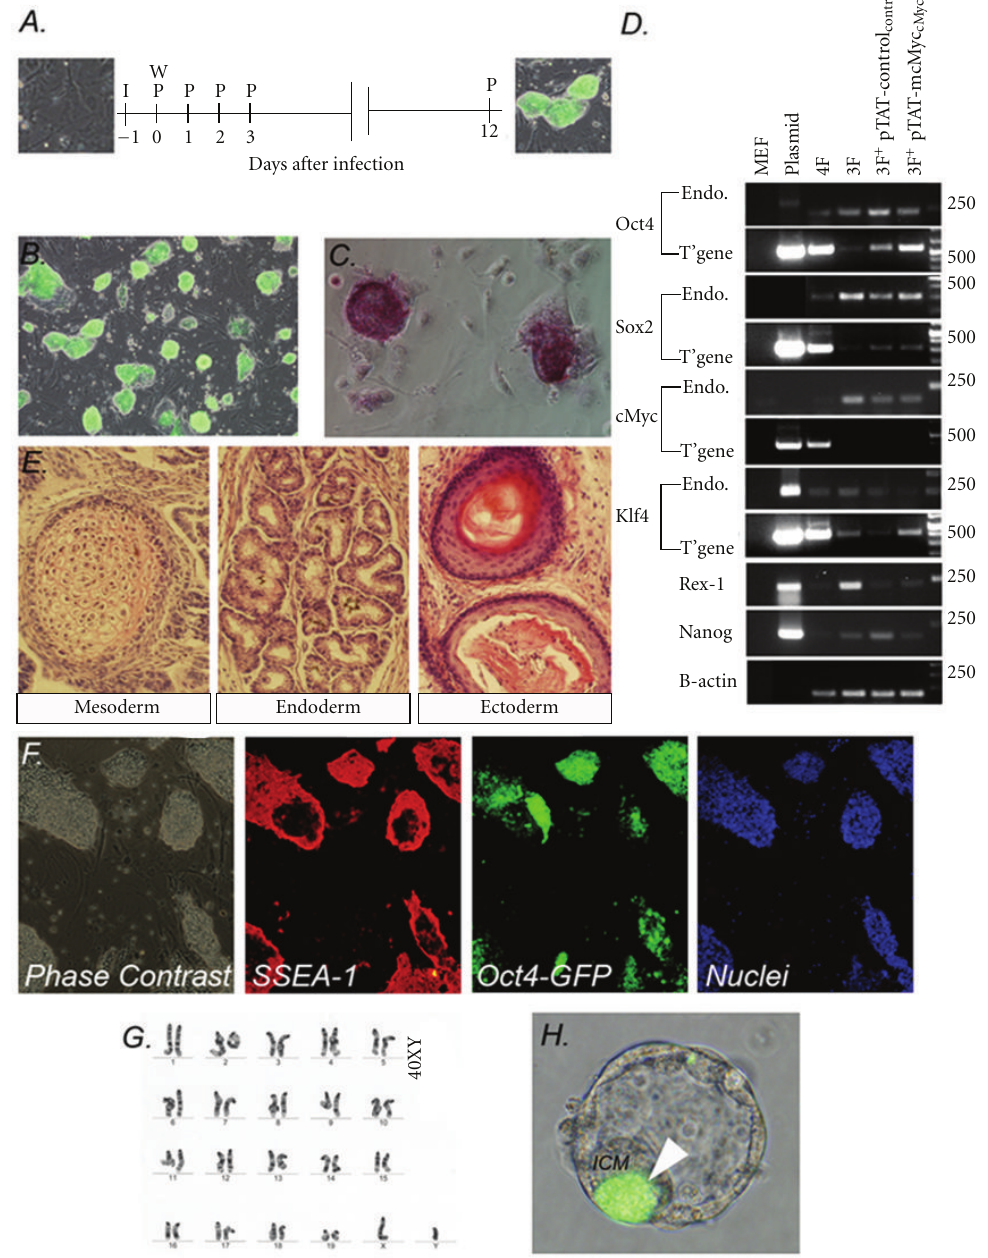
Figure 3: OSK + pTAT-mcMyc treated MEF display the hallmarks of pluripotency. (A) Schedule for pTAT-mcMyc treatment of somatic cells. MEF were infected for 24 hours (“I”) before retrovirus was washed from cells (“W”) and pTAT-mcMyc and control recombinant protein applied (day 0; “P”). Protein was applied daily for 12 days. (B) Oct4-GFP + clone Tatc1 from Oct4/Sox2/Klf4 + pTAT-mcMycs treated cells. (C) Confirmation of alkaline phosphatase expression in clone Tatc1. (D) RT-PCR confirms Tatc1 expresses endogenous markers Oct4, Sox2, cMyc, Klf4, Rex-1, and Nanog (“Endo”). We further confirmed this clone was not contaminated with mcMyc transgene by PCR using genomic DNA template (“T’gene”; all oligonucleotides outlined elsewhere) [1]. (E) Following injection into SCID mice, Tatc1 form teratomas with di ff erentiated cells characteristic of the three germ layers (cartilage characteristic of endoderm, glandular tissue reminiscent of mesoderm, and neural rosettes characteristic of ectoderm). (F) Immunocytochemistry confirms Tatc1 expresses pluripotency marker stage-specific embryonic antigen-1 (SSEA1). (G) Reprogramming of MEF to Tatc1 maintained normal karyotype (40XY). (H) Following aggregation with 2.5dpc embryos, Oct-GFP + Tatc1 cells contribute to the inner cell mass (labeled “ICM”) of subsequent 4.5dpc blastocysts